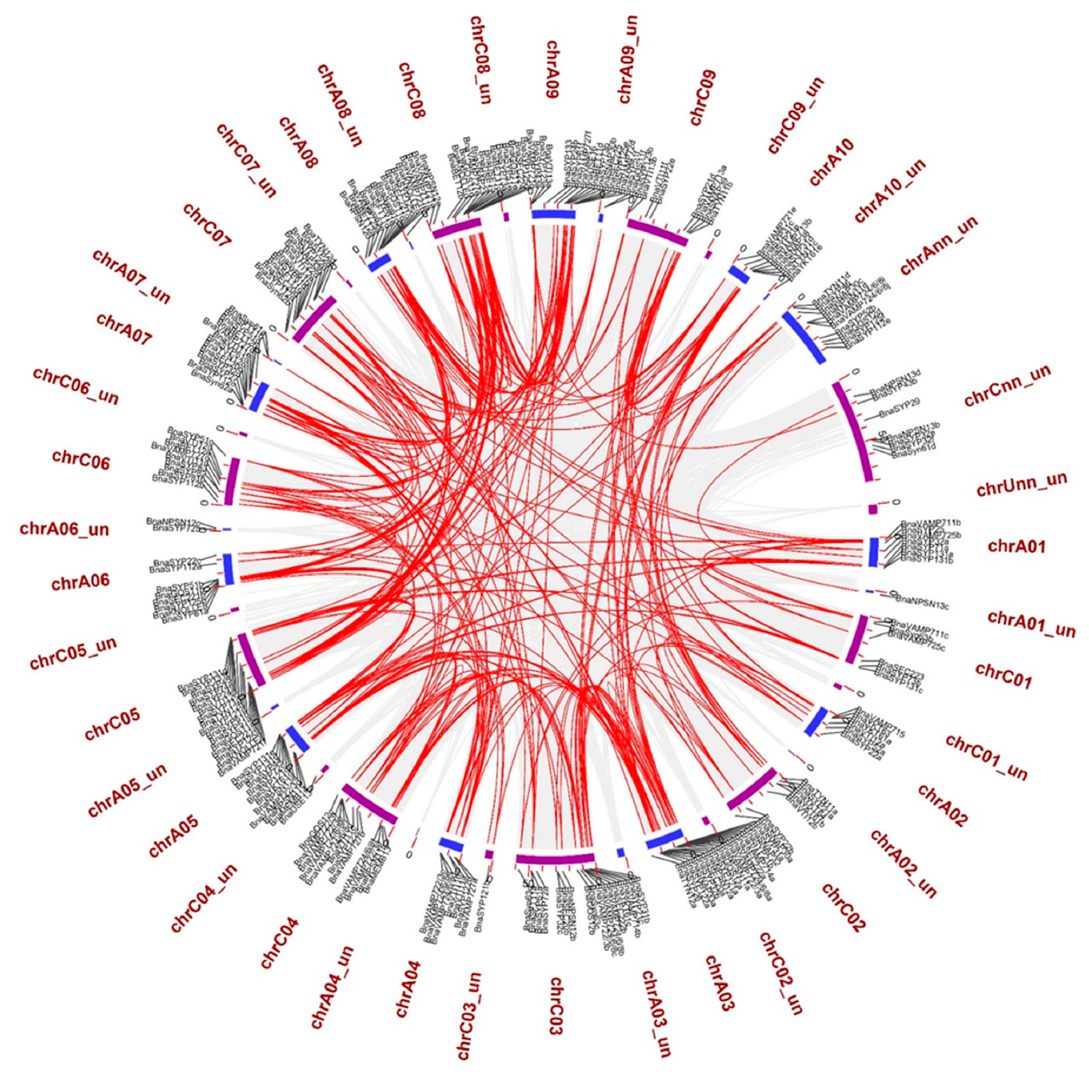
Figure 4. The locations on chromosomes and homologous relationships of the BnaSNAREs . All BnaSNAREs were mapped to their respective locus in the B. napus genome in a circular diagram using Advanced Circos of TBtools. An and Cn sub-genomes are indicated by shades of blue and purple colors.